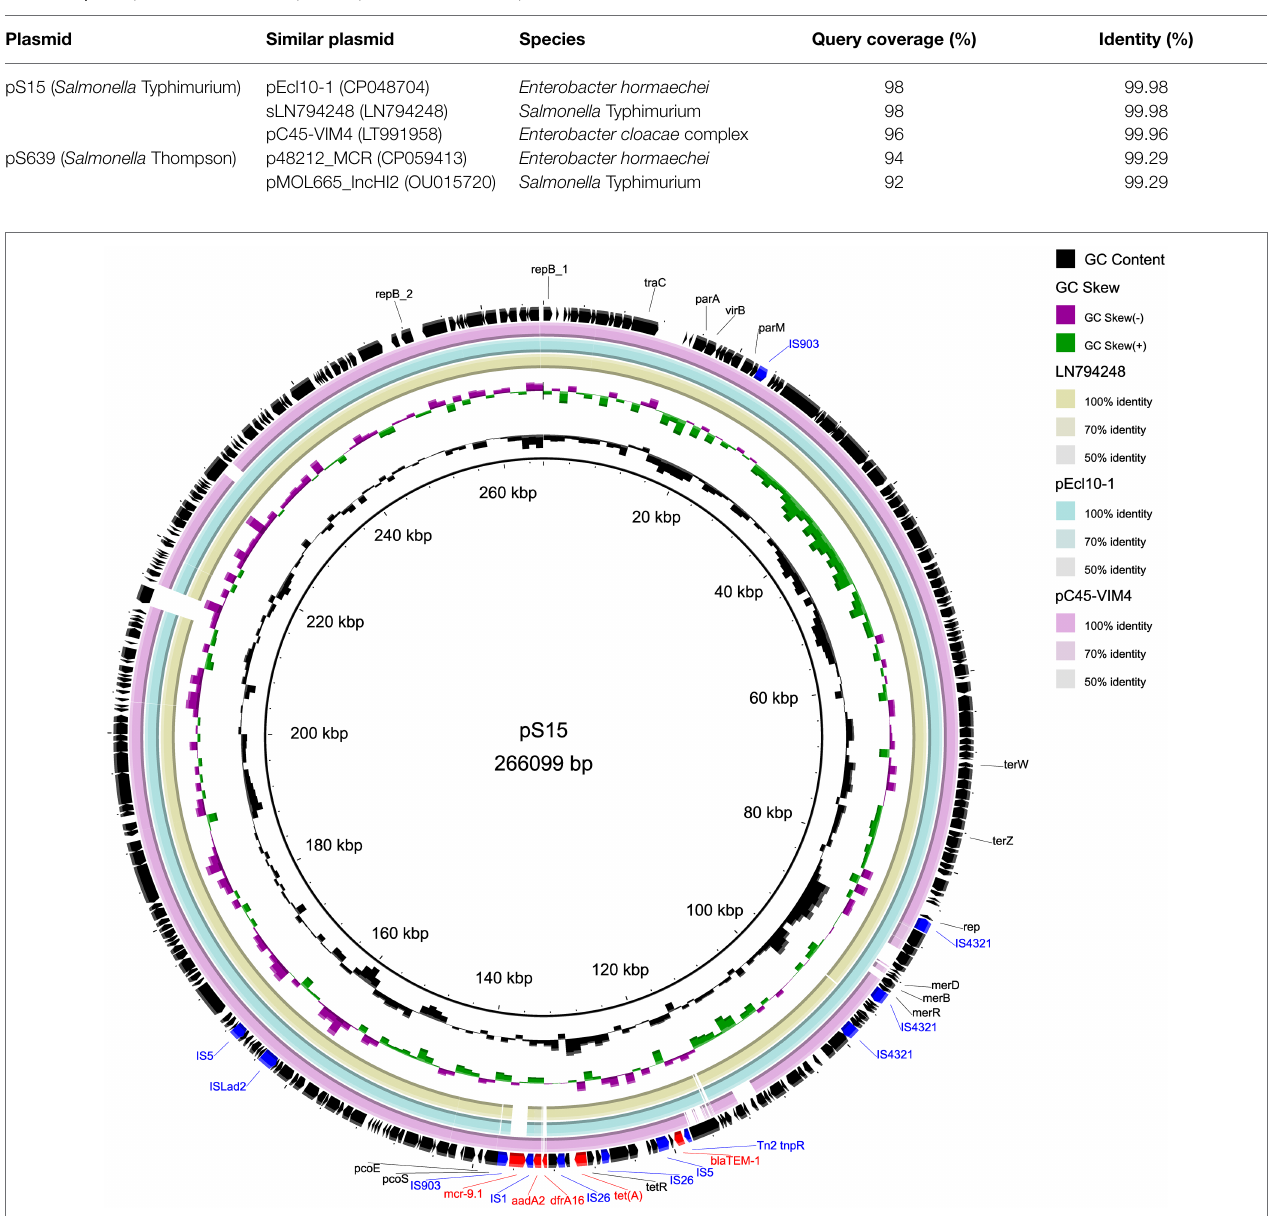
FIGURE 1 | Comparison of circular structures of pS15 and its similar plasmids. Arrows indicate the direction of predicted transcription of each gene. Red arrows indicate antibiotic resistance genes. Blue arrows indicate insertion sequences.